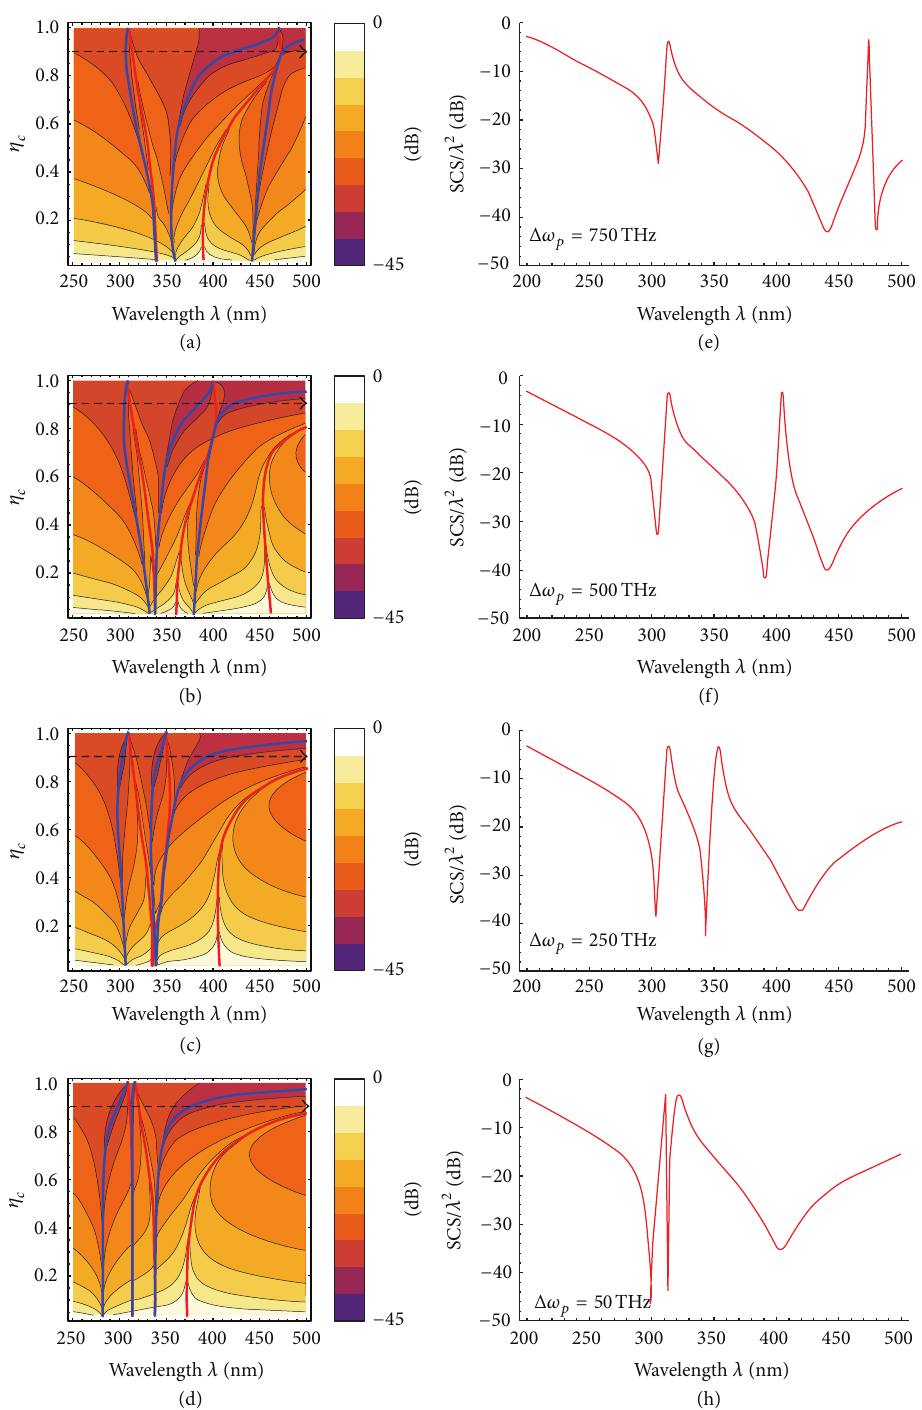
Figure 2: (a)–(d) Contour plots of the total SCS (normalized to the maximum value) as a function of the wavelength and the aspect ratio 𝜂 𝑐 and (e)–(h) normalized SCS /𝜆 2 versus wavelength, for different plasma frequencies in the two plasmonic layers of the structure in Figure 1(a): (a), (e) Δ𝜔 𝑝 = 750 THz, (b), (f) Δ𝜔 𝑝 = 500 THz, (c), (g) Δ𝜔 𝑝 = 250 THz, and (d), (h) Δ𝜔 𝑝 = 50 THz. The aspect ratio is fixed to 𝜂 𝑐 = 0.91 (indicated by the dashed arrow in panels (a)–(d)). Cloaking (blue lines) and resonant scattering (red lines) quasi-static conditions are also shown in the contour plots